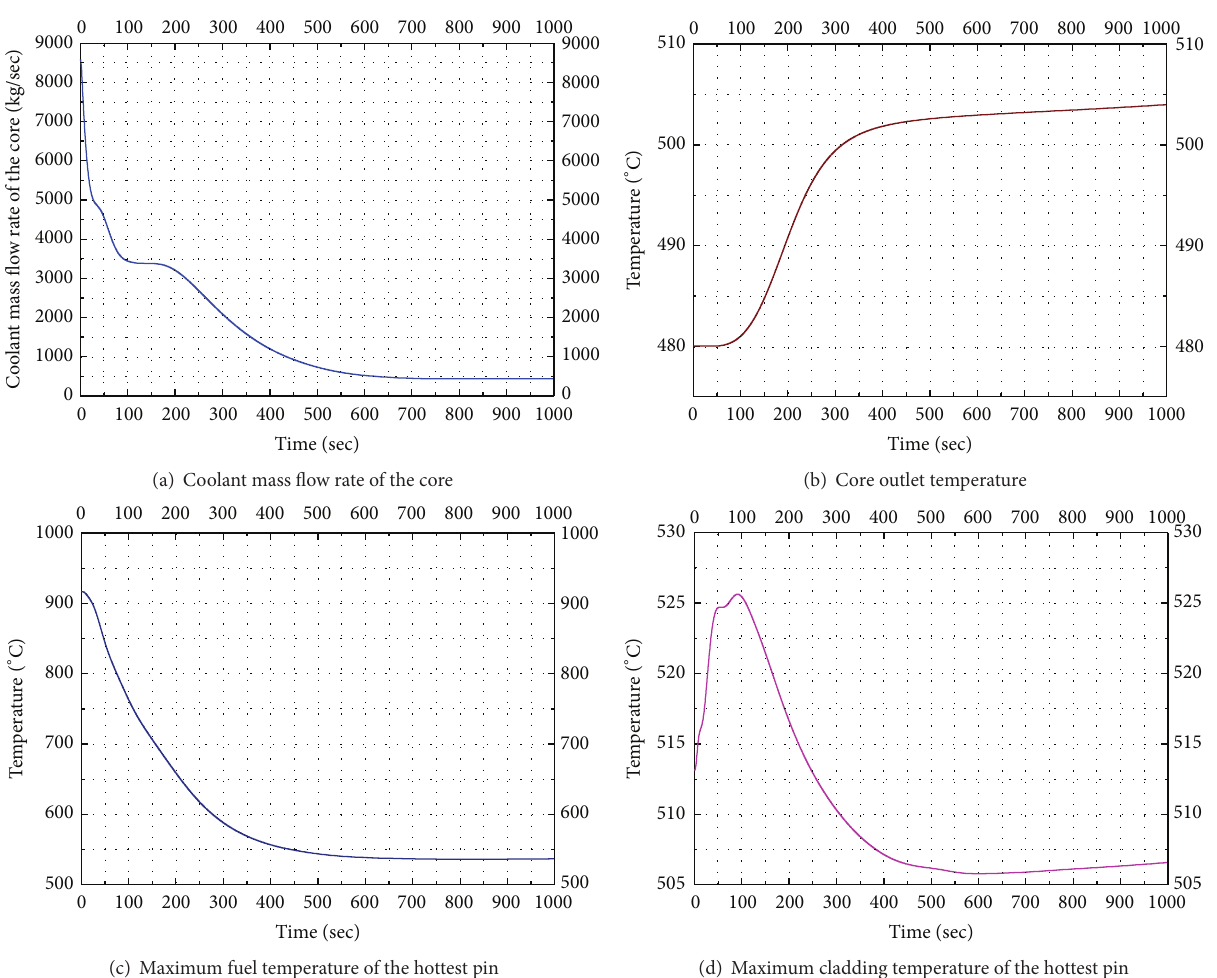
Figure 16: Results for ULOHS transient for